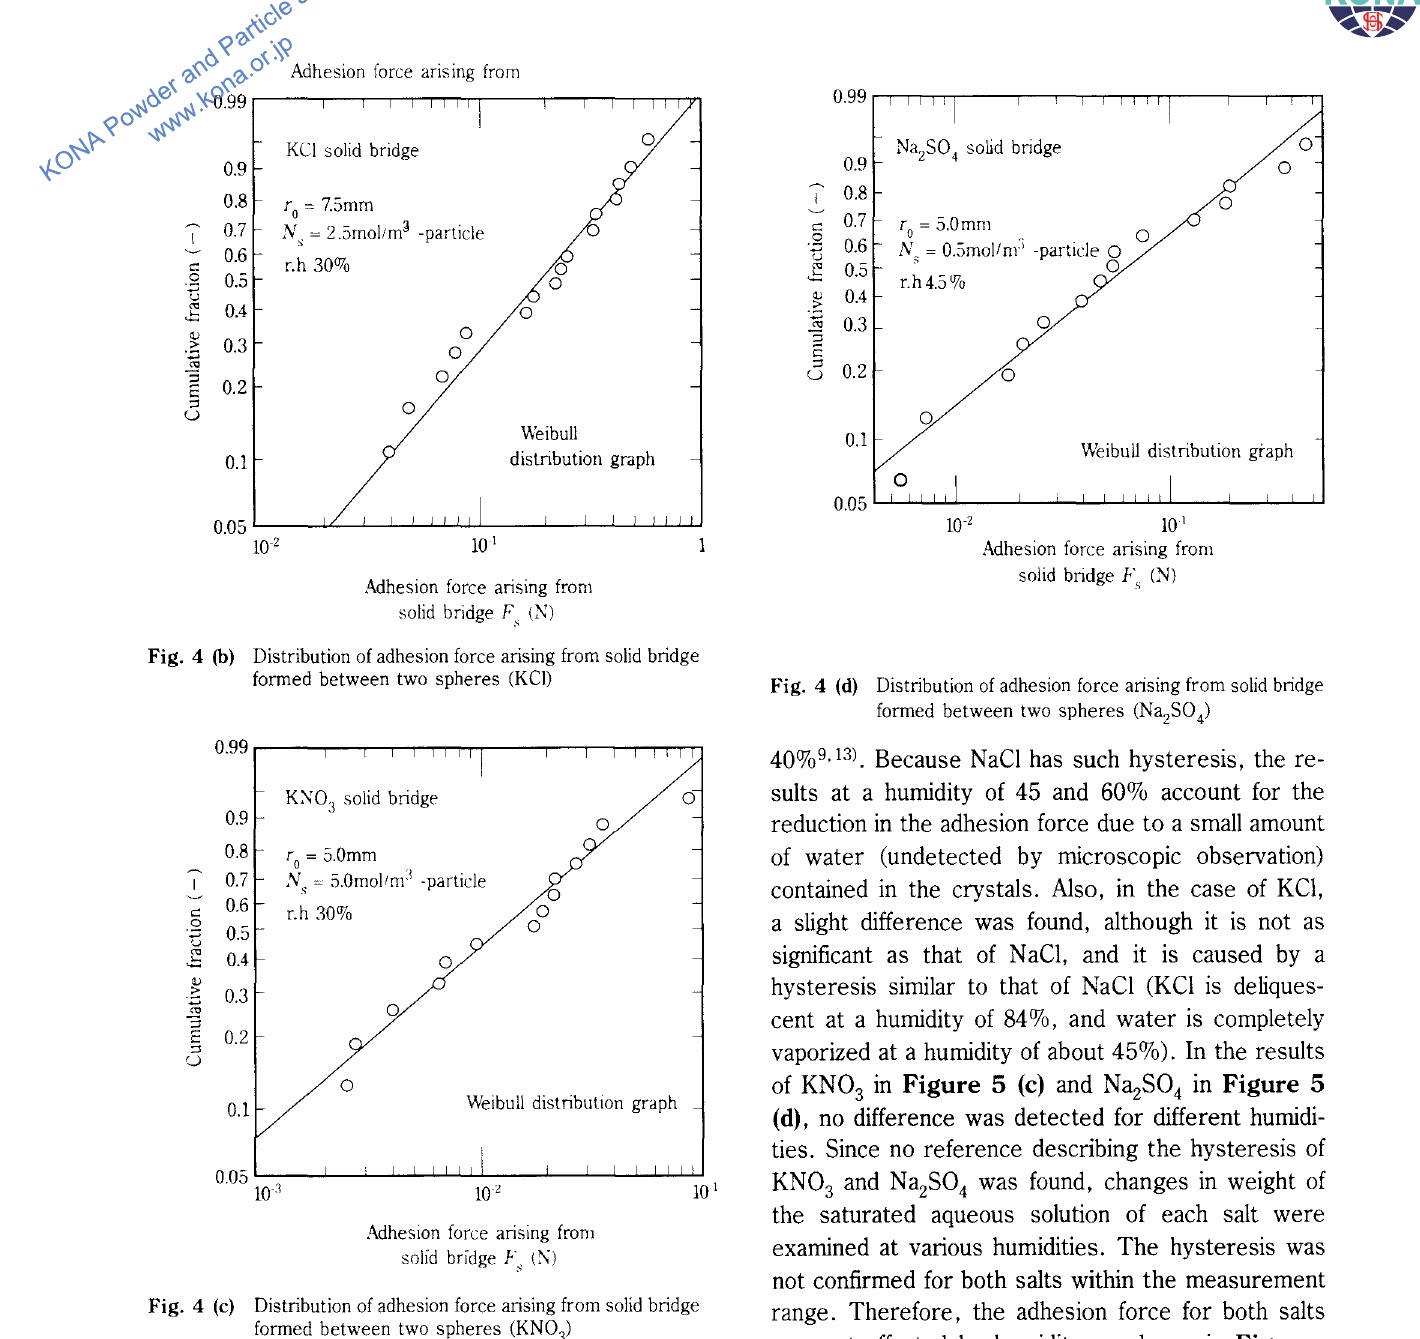
Fig. 4 (d) Distribution of adhesion force arising from solid bridge formed between two spheres (Na 2 SO 4) 40o/o 9·13l. Because NaCI has such hysteresis, the re sults at a humidity of 45 and 60% account for the reduction in the adhesion force due to a small amount of water (undetected by microscopic observation) contained in the crystals. Also, in the case of KCl, a slight difference was found, although it is not as significant as that of NaCI, and it is caused by a hysteresis similar to that of NaCl (KCl is deliques cent at a humidity of 84%, and water is completely vaporized at a humidity of about 45%). In the results of KN0 in Figure 5 (c) and Na S0 in Figure 5 4 2 3 (d), no difference was detected for different humidi ties. Since no reference describing the hysteresis of KN0 and Na S0 was found, changes in weight of 4 3 2 the saturated aqueous solution of each salt were examined at various humidities. The hysteresis was not confirmed for both salts within the measurement range. Therefore, the adhesion force for both salts was not affected by humidity as shown in Figures 5 (a) and (d). Figure 6 shows photographs of a NaCl solid bri dge formed between glass spheres. In Figure 6 (a) (before breakage), it is recognized that the profile of the solid bridge is similar to that of the liquid bridge in Figure 1, and the solid bridge is formed so as to fill the gap between the glass spheres. A solid bridge of substantially similar profile was formed in other salts, KCl, KN0 and Na S0 4. In Figure 6 (b) 3 2 (breakage section viewed from above), because the solid bridge has some local voids, and has not a uni form structure, the individual measurement data for adhesive force are distributed within a wide range as shown in Figure 4. Although the adhesive